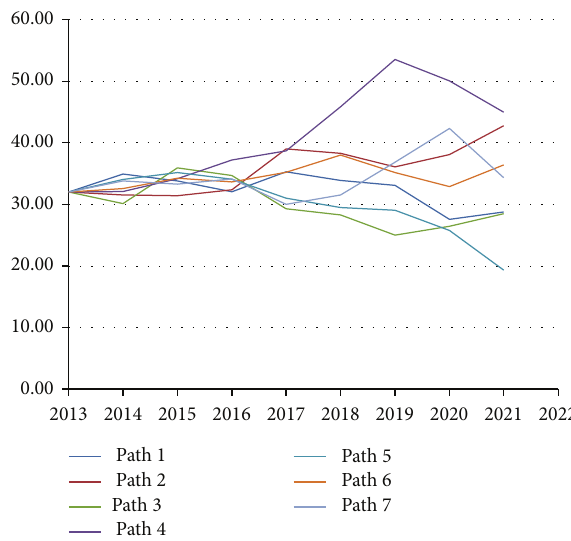
Figure 3: Seven simulated operating cost paths on a yearly time